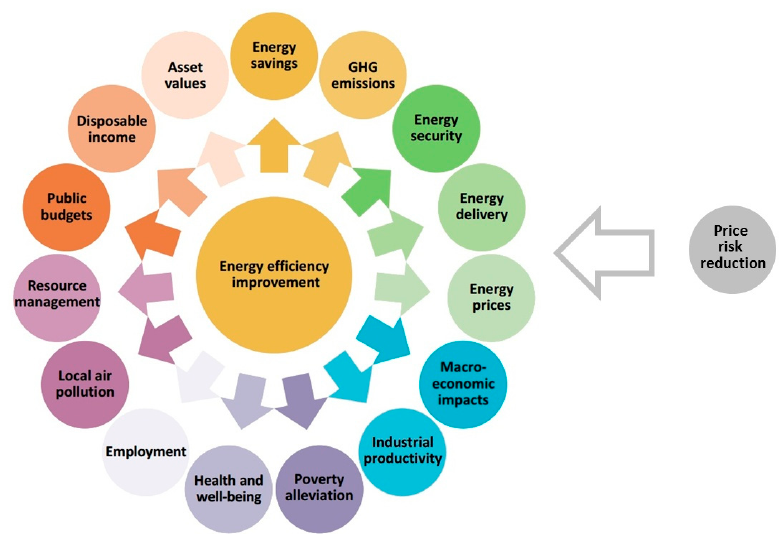
Figure 1 . The most prominent types of multiple benefits of energy efficiency improvements, as listed by the International Energy Agency (IEA) [14], are supplemented by the value of price risk reduction. This figure is adapted from a graphic by IEA [14].